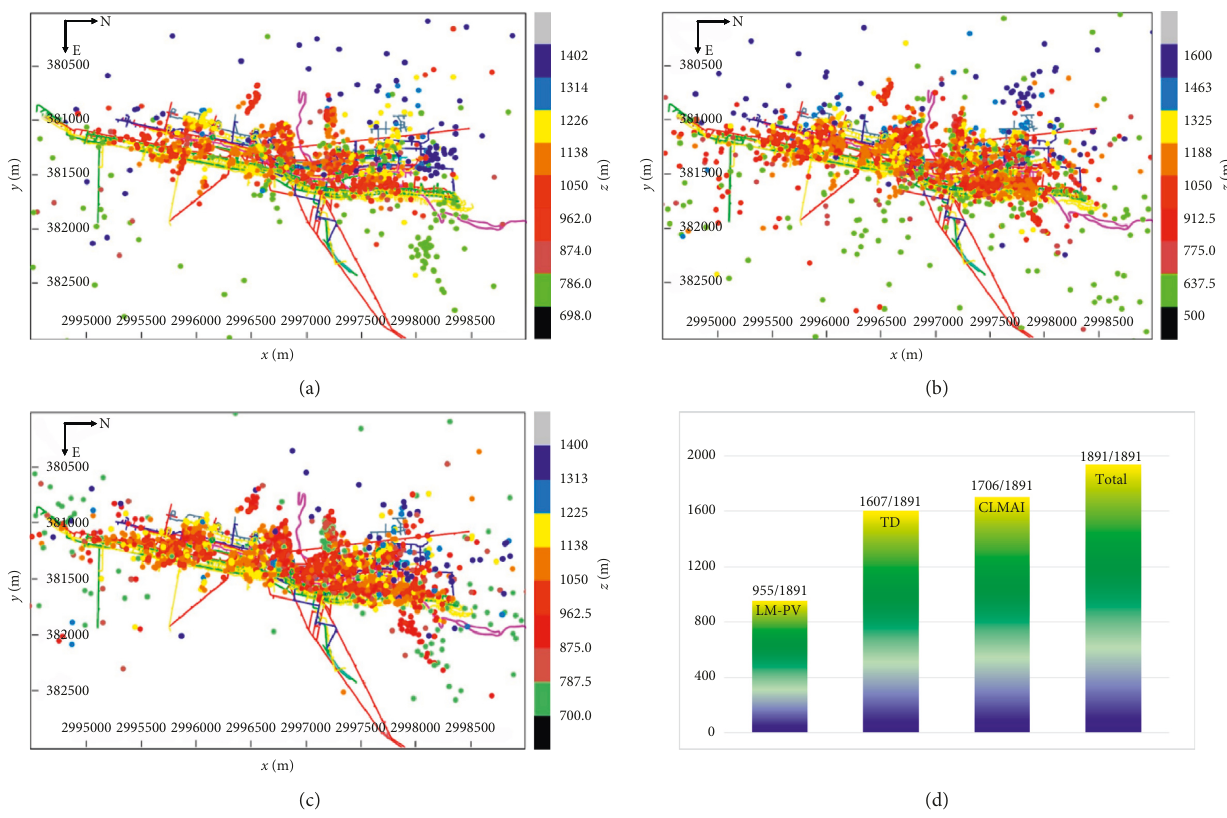
Figure 6: Locating results of 1891 events using three methods. (a) The locating results of the LM-PV method. (b) The locating results of the TD method. (c) The locating results of the CLMAI method. (d) The number of effective results for the three methods (from